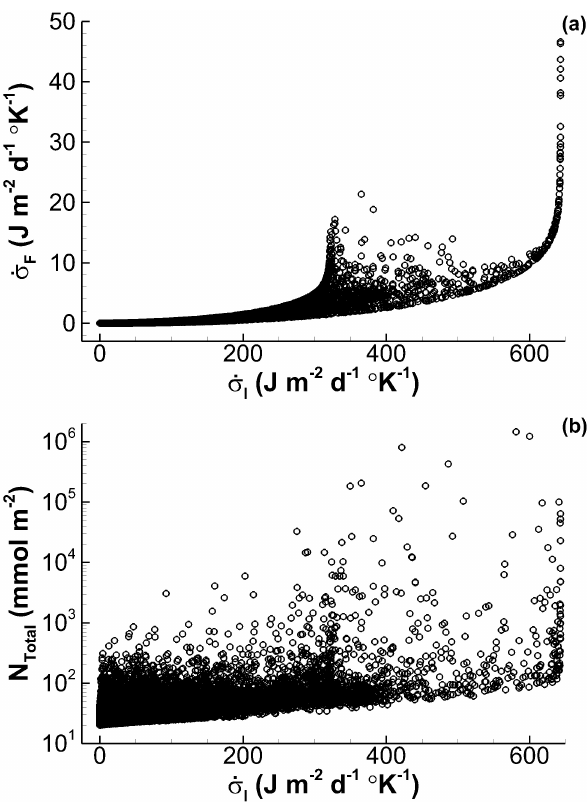
Fig. 4. Extracted results from the 100000 Monte Carlo simulations with randomly selected ε i [ j ]. (a) Comparison of entropy of mixing, Eq. (13), as a function of total internal entropy production from Eq. (16). (b) Total steady state N standing stock ( N Total ) given by Eq. (20) as a function of total internal entropy production.